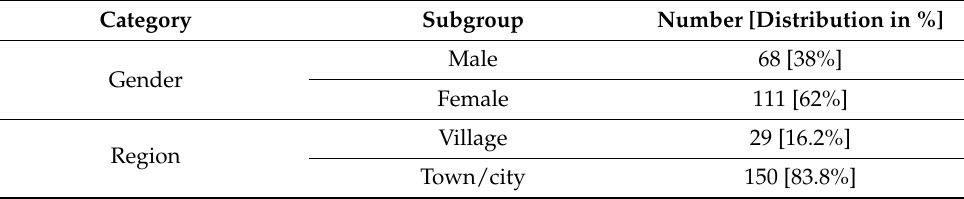
Table 1. Demographic characteristics of patients with acromegaly ( n = 179).